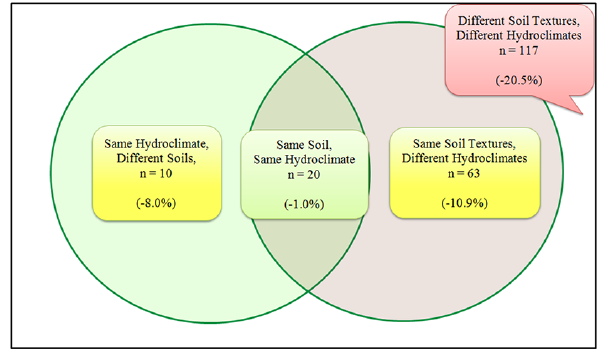
Figure 13. Venn diagram of modeling errors with similar and dif- ferent soils and